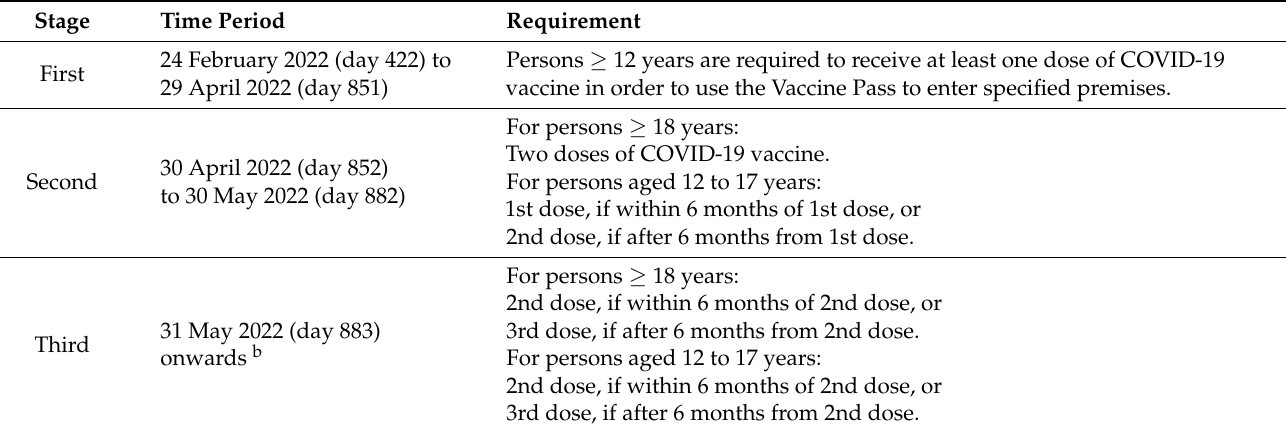
Table 5. Implementation of the Vaccine Pass to enter specified premises in order to enhance COVID-19 vaccination coverage in Hong Kong up to 25 September 2022 (day 1000) a .